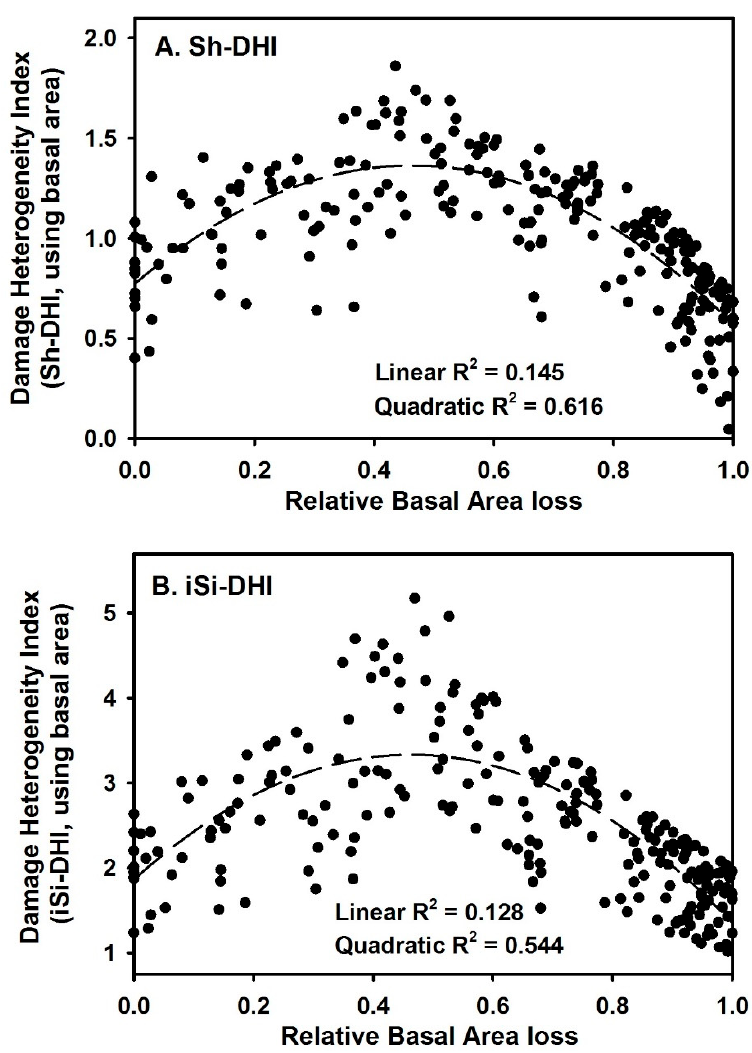
Figure 8. Damage heterogeneity index in relation to severity of damage, using plots sampled with 5-cm diameter minimum. ( A ) Sh-DHI, calculated with the Shannon index; ( B ) iSi-DHI, calculated with the inverse Simpson index. In all calculations of damage heterogeneity above, the measure of abundance used was the cumulative basal area in each damage category for that plot. Variance explained (R 2 ) by linear and quadratic regressions was compared to determine if the relationship between DHI and severity was significantly curved.